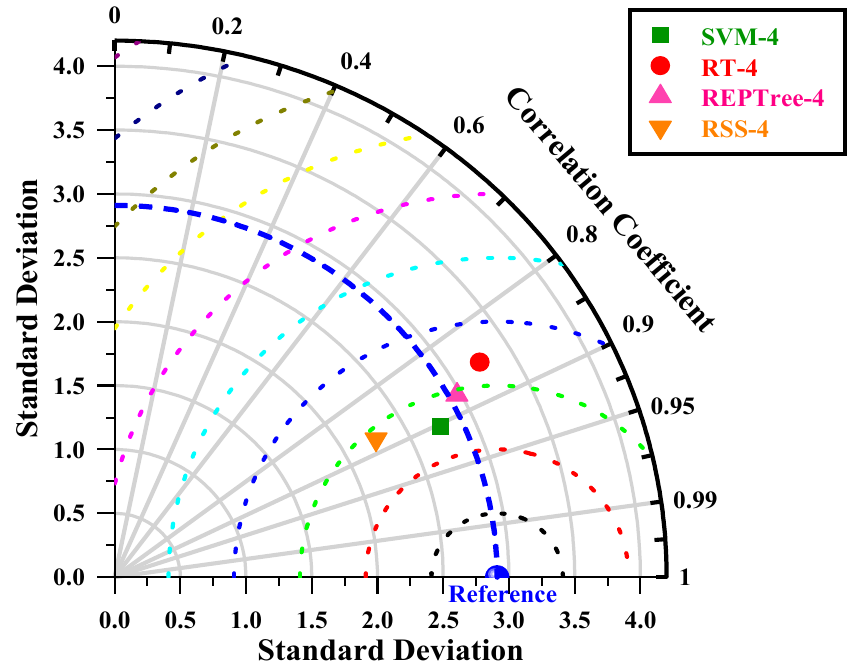
Figure 14. Taylor diagrams of SVM-4, RT-4, REPTrees-4, and RSS-4 during testing span at the New Delhi station.